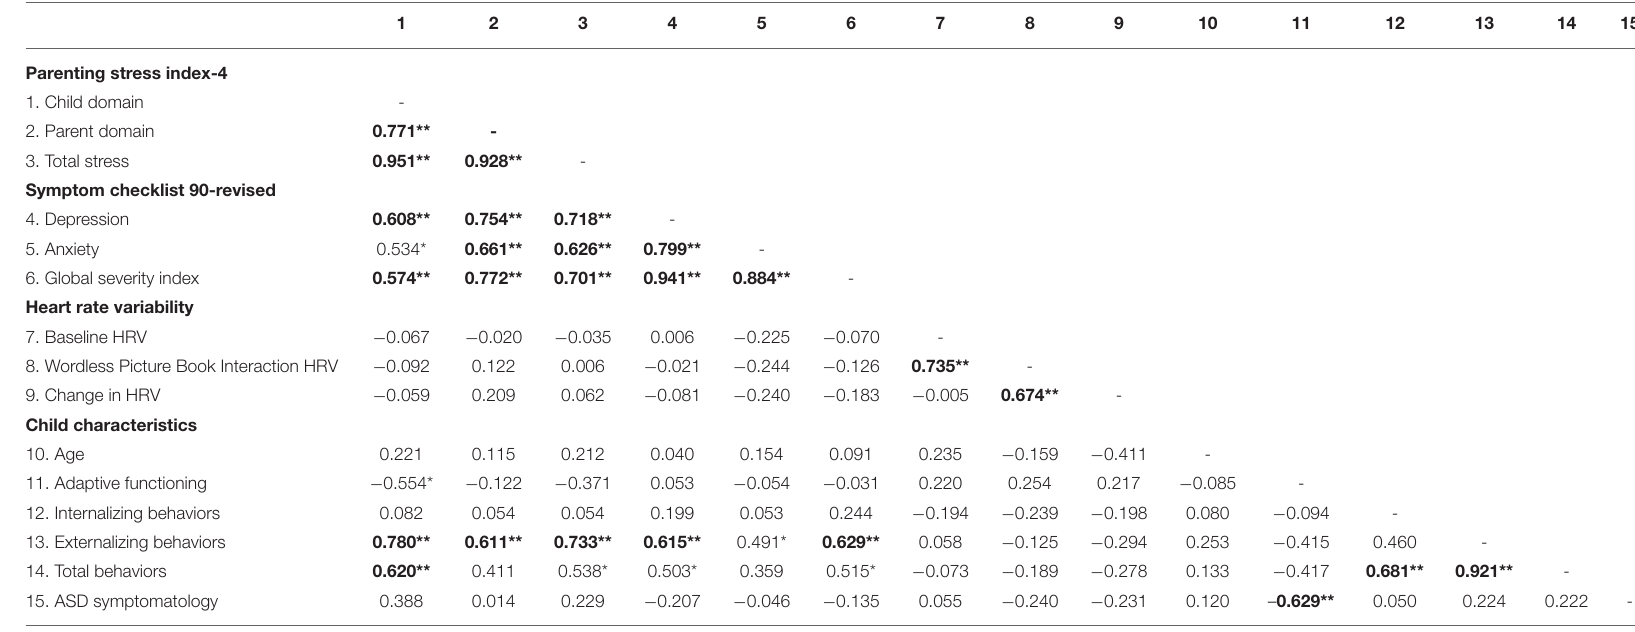
TABLE 3 | Correlations between maternal measures of mental health and stress and child